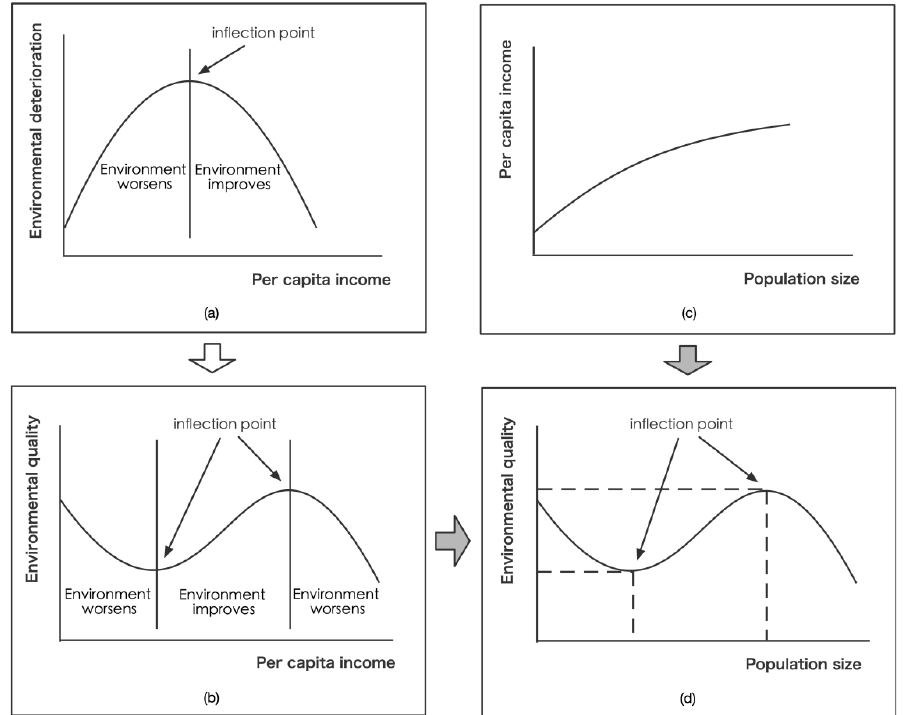
Figure 2. Derivation diagram of the relationship between population size and environmental quality: ( a ) environmental Kuznets curve; ( b ) graph of the relationship between population size and per capita income; ( c ) long-term relationship between per capita income and environmental quality; ( d ) diagram of the relationship between population size and environmental quality.